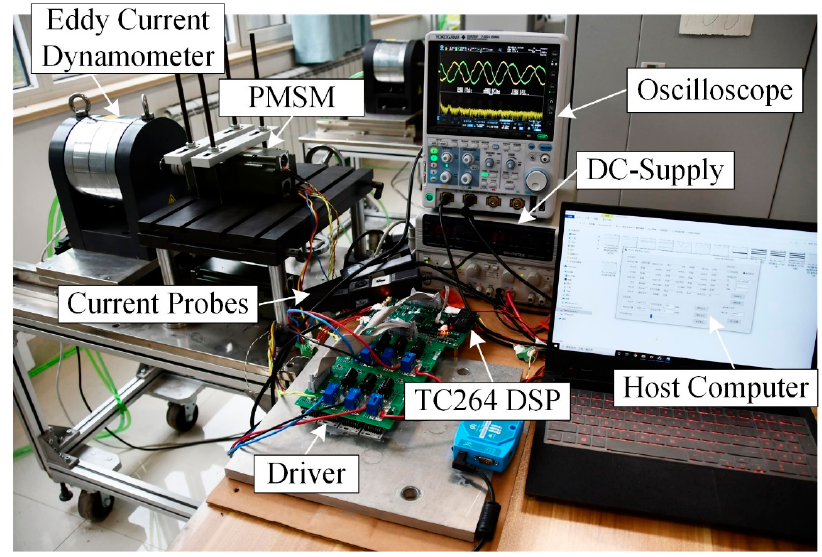
Figure 6. Integrated three-phase PMSM experimental platform.